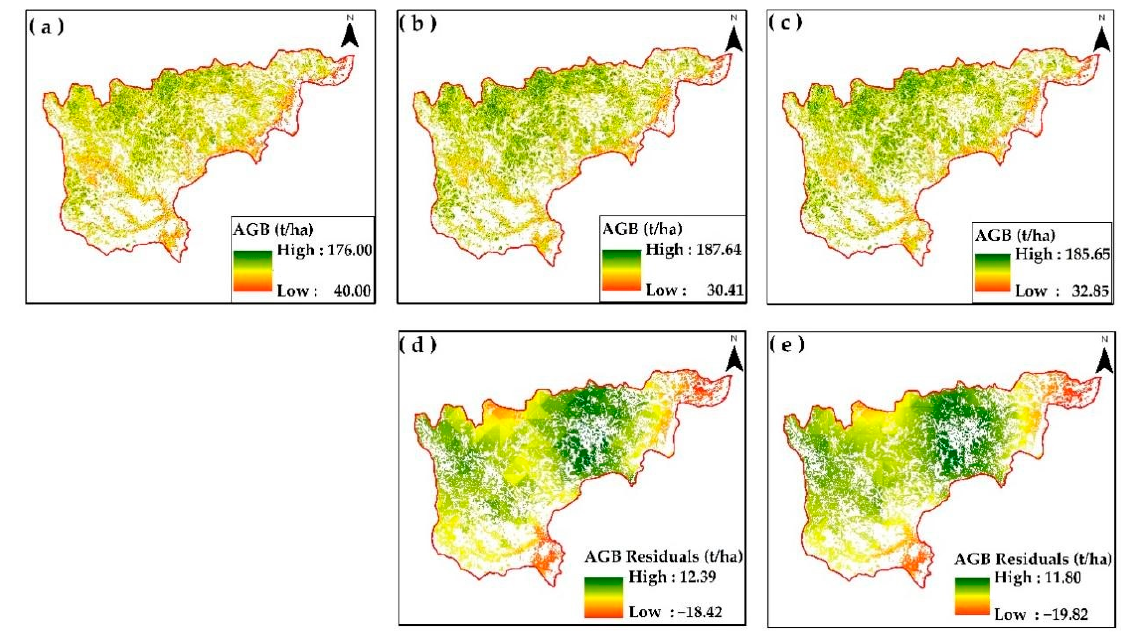
Figure 10 . The estimated AGB of deciduous forests in the YM from ( a ) RF, ( b ) RFOK, and ( c ) RFCK models, and the calculated residuals for ( d ) RFOK and ( e ) RFCK models.